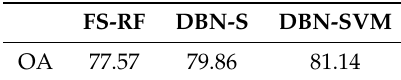
Table 13. Overall accuracy (OA) (%) for independent test set. FS-RF: random forest with feature selection method. DBN-S: deep belief network (DBN) with softmax classifier. DBN-SVM: the fused model of DBN and support vector machine.